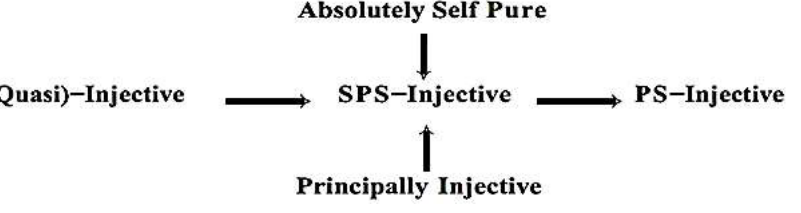
Figure 1: Strongly principally self-injective modules.